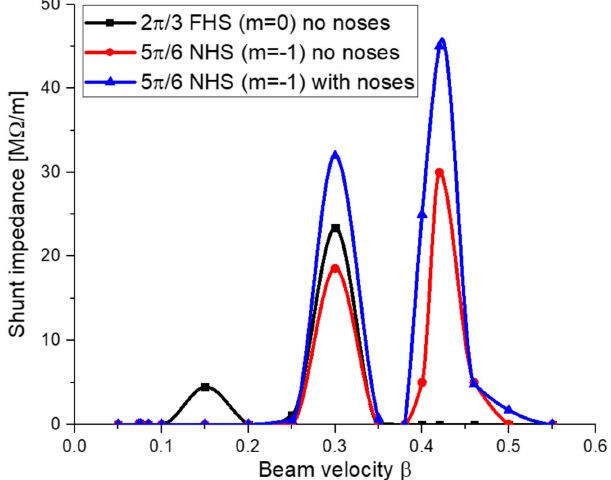
FIG. 9. Shunt impedance of the 20-cells BTW structures with different geometry and designed to operate at different spatial harmonics, as a function of beam velocity. The geometry of FHS and NHS cells with no noses is similar except for the cell length.